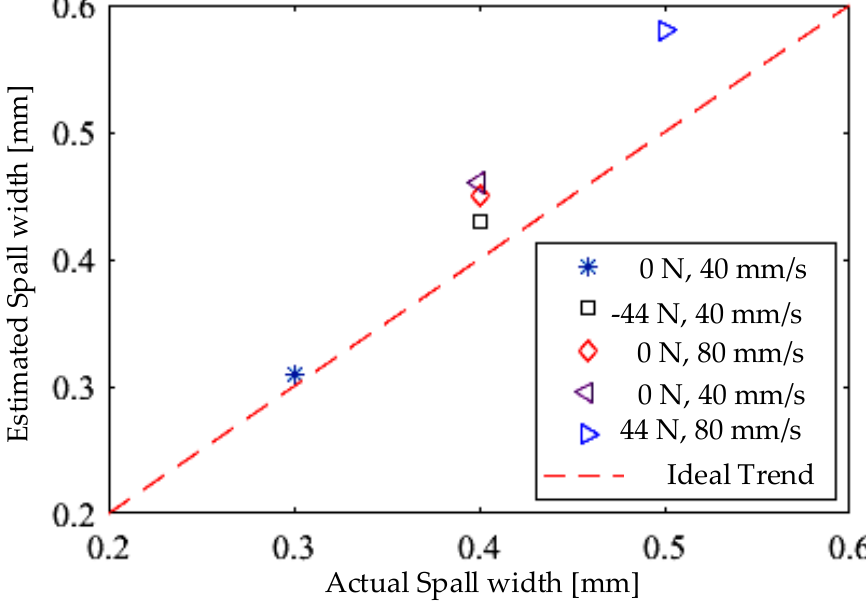
Figure 12. Overall quantification results for FLEA data for 5 datasets.